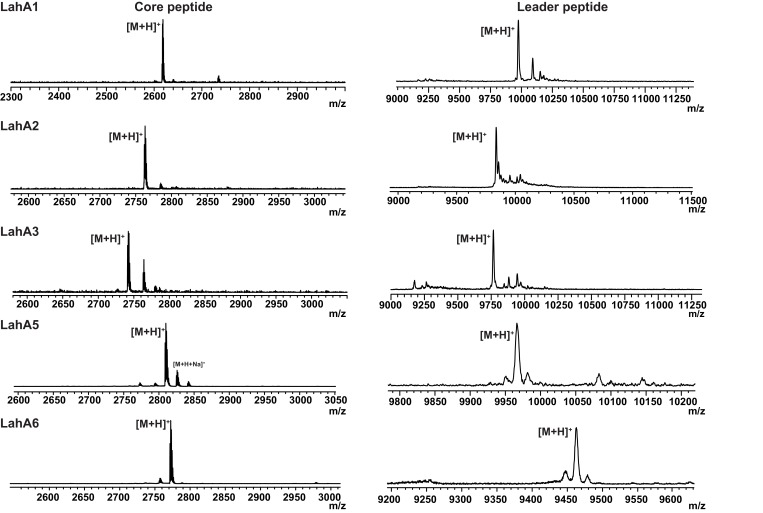
LahT150 cleaves all LahA peptides.MALDI ToF MS analysis of LahA peptides treated with LahT150. Core peptide ([M + H]+) masses: LahA1 (theor 2616.4; obs 2616.5). LahA2 (theor 2761.4; obs 2762.0). LahA3 (theor 2740.4; obs 2740.7). LahA5 (theor 2811.4; obs 2810.8). LahA6 (theor 2771.4; obs 2771.4). Leader peptide average [M + H]+ masses: LahA1-leader (theor 9973.6, obs 9973.3), LahA2-leader (theor 9827.6, obs 9830.1), LahA3-leader (theor 9756.5, obs 9751.2); LahA5-leader (theor 9964.8, obs 9969.1), LahA6-leader (theor 9458.6, obs 9462.9).